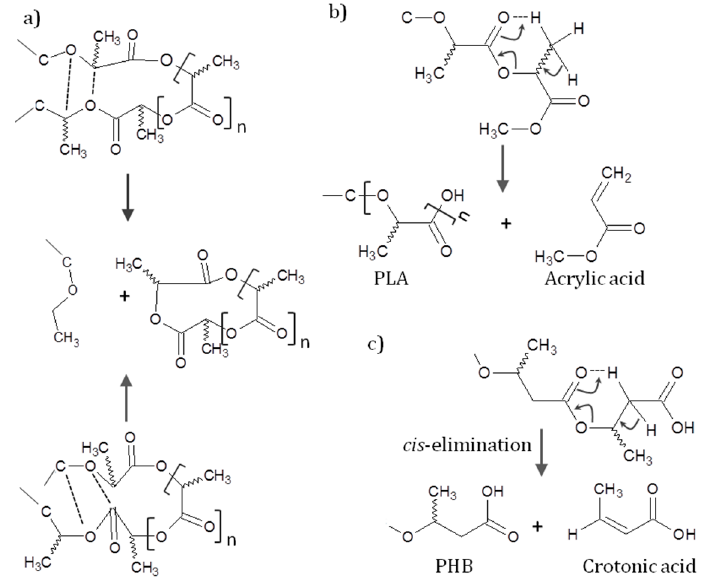
Figure 2. Non-radical thermal degradation of PLA: ( a ) trans-esterification; ( b ) cis -elimination (adapted from Kopinke et al. [101]); and ( c ) non-radical thermal degradation of PHB cis -elimination (adapted from Aoyagi et al. [102]).